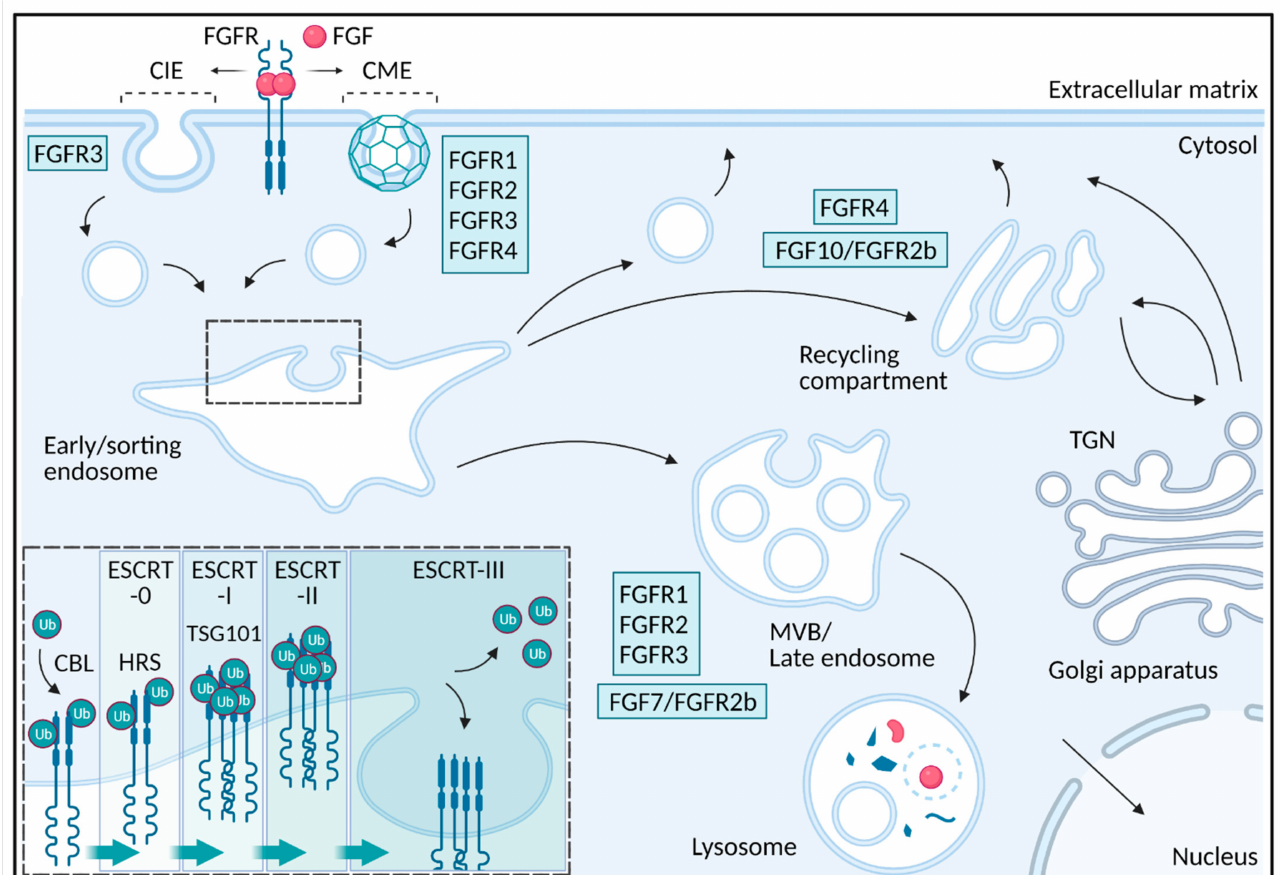
Figure 2. Endocytosis of FGFs/FGFRs. Once activated by ligand-binding, FGFRs can be internalized via clathrin-mediated endocytosis (CME) and clathrin-independent endocytosis (CIE). While FGFR1, 2 and 4 are mainly internalized via CME, FGFR3 seems to be internalized partly by CME and partly by CIE mechanisms. Once internalized, the ligand-receptor complexes are localized to early/sorting endosomes from which they can be sorted to recycling either directly or via the endocytic recycling compartment or to degradation in lysosomes via multivesicular bodies (MVB) and late endosomes. FGFRs destined for degradation in lysosomes are tagged by the attachment of ubiquitin (Ub). Ubiquitination of FGFRs seems to be dependent on the E3 ubiquitin ligase CBL. Ubiquitinated receptors are then recognized by the ESCRT complexes (ESCRT-0-III) and sorted into intraluminal vesicles originating at the endosomal membrane. Ub is removed before internal- ization. At least two components of the ESCRT machinery have proven important for FGFR sorting into the degradative pathway, namely HRS of ESCRT-0 and TSG101 of ESCRT-I. The decision to degrade or not, depends on the receptor type as well as the bound ligand. FGFR4 seems to be mainly recycled while FGFR1, 2 and 3 are sorted more efficiently to lysosomal degradation. FGFR2b bound to FGF7 is sorted for degradation while FGFR2b bound to FGF10 is recycled. In both cases the decision to degrade or not, seems to depend on the levels of receptor ubiquitination. The recycling of FGFR4 might also occur via TGN (trans Golgi network). Moreover, both FGFs and FGFRs can translocate to the nucleus. Created with BioRender.com, accessed on 1 May